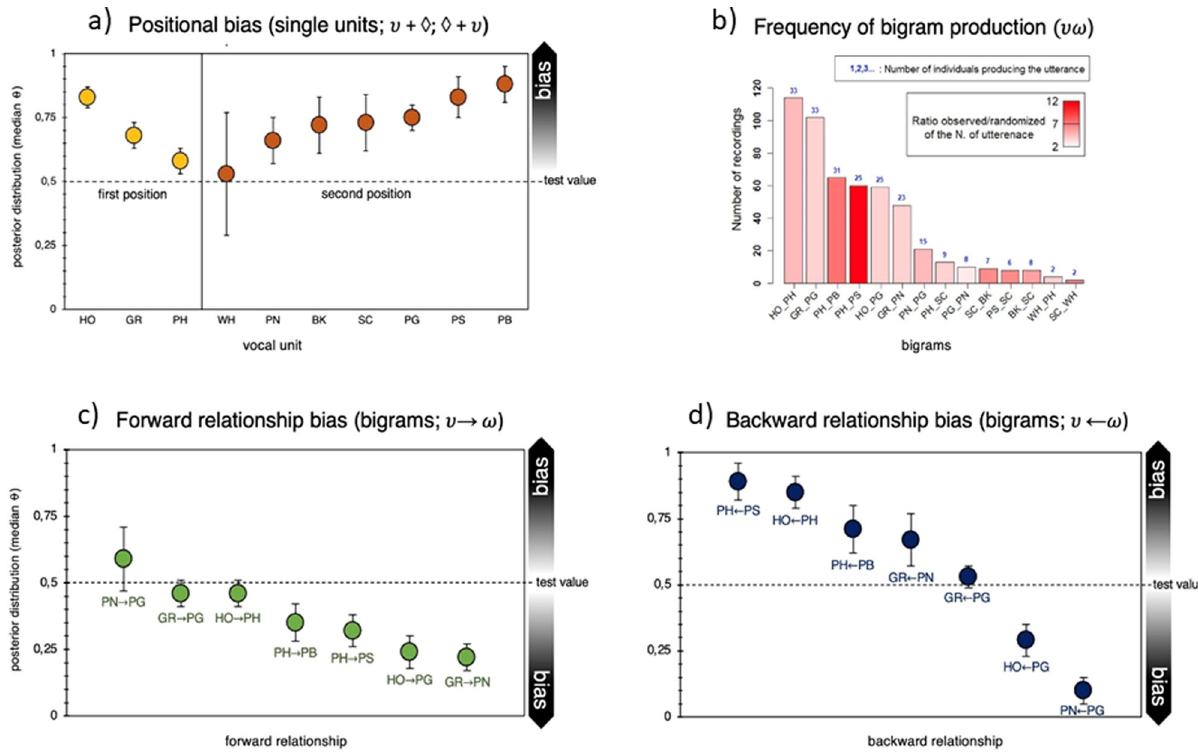
Fig. 3 Positional bias, speci fi c ordering frequency, and transitional bias for two-unit sequences (bigrams). a Likelihood for a certain unit υ to occur in fi rst position (yellow) or in second position (orange) in two-unit utterances, expressed as median posterior distribution ( θ ). Bars stand for Credible Intervals (CI) at 95%. ♢ = irrespective of unit type (see Table 3). b Frequency of production of the bigrams that were produced above chance (i.e., >95% more likely than by random juxtaposition of single units). The height of each bar corresponds to the number of times each utterance was recorded. The color gradient in the bars depicts the number of times each utterance was observed divided by the number of times each utterance was present on average in each randomization (averaged over 1000 randomizations). The color ranges from the lowest ratio in white (i.e., the utterance was present in the observed data two times more than in the randomization) to the highest ratio in red (i.e., the utterance was present in the observed data 12 times more than in the randomized data). The number on top of each bar in blue indicates the number of individuals that produced each utterance. c Likelihood for a certain unit ð υ Þ in fi rst position to be in a forward relationship (green) with a certain unit ω ð Þ in second position (see Table 3). d Likelihood for a certain unit ω ð Þ in second position to be in a feedback relationship (blue) with a certain unit ð υ Þ in fi rst position, in two-unit utterances (see Table